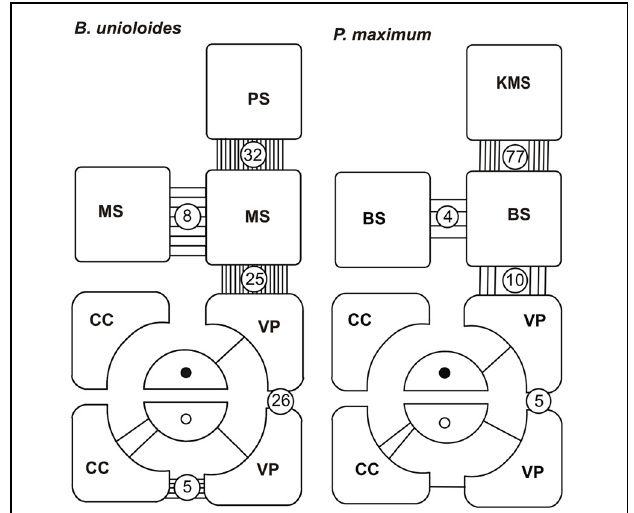
FIGURE 18 | Plasmodesmograms showing the distribution of plasmodesmata, expressed as percent plasmodesmata/ µ m cell-wall interface for the C 3 grass, Bromus unioloides and the C 4 grass Panicum maximum expressed as percent plasmodesmata/ µ m vein. B. unioloides has a double sheath—an outer parenchyma sheath (PS) and an inner thick-walled mestome sheath (MS). In Panicum maximum the Kranz mesophyll sheath (KMS) surrounds the inner bundle sheath (BS). Note that thick-walled sieve tubes (TSTs, solid dots) do not have connections to the ST-CC (open circles) complex. STs and TSTs have low frequency connections to vascular parenchyma cells (VP). Redrawn from Botha and van Bel